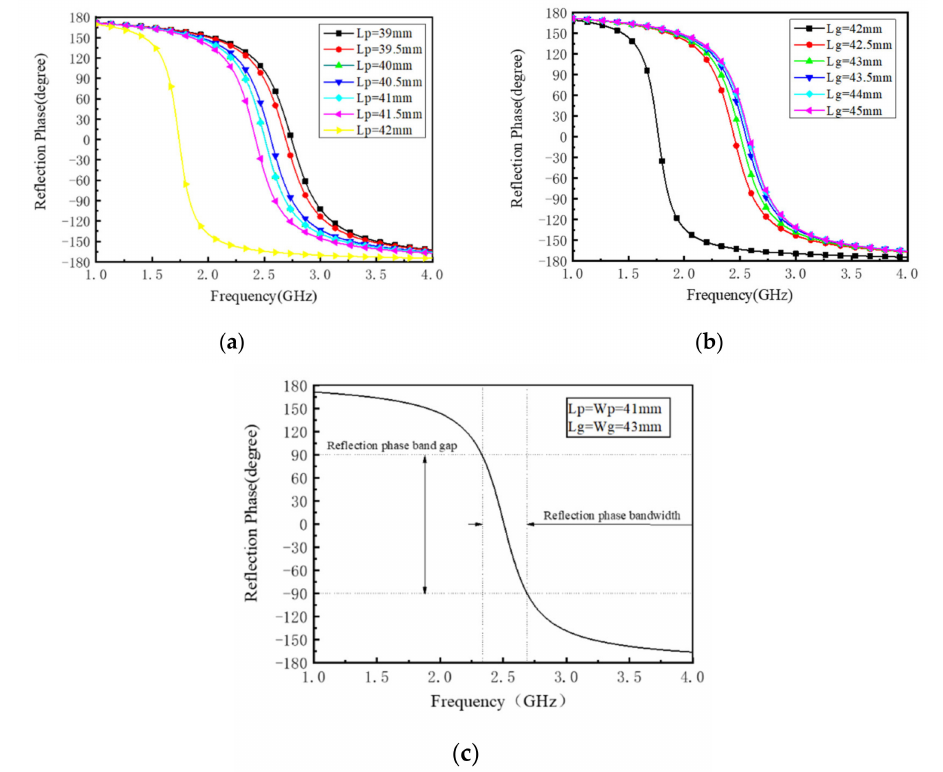
Figure 8. Reflection phase curve of the AMC element: ( a ) Lp effect on the reflection phase, ( b ) Lg effect on the reflection phase, ( c ) the reflection phase of the final AMC unit